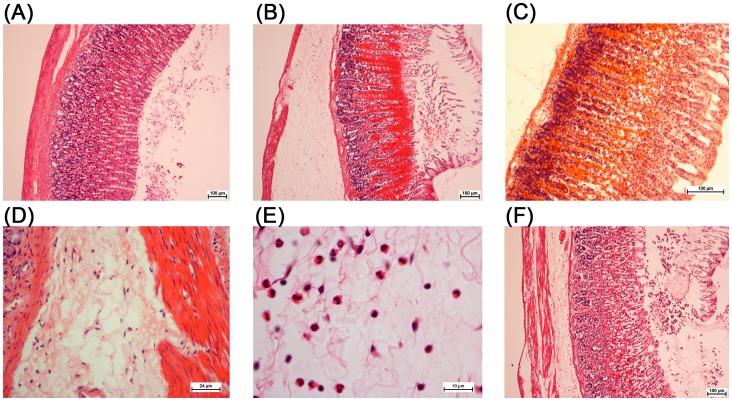
Hematoxylin and eosin staining evaluation of the gastric mucosa.The negative control and the complex control group have not any disruption to the gastric epithelium, submucosal edema or leucocyte infiltration (A). The lesion control group has extensive edema in the submucosal layer (B). Moreover acute hemorrhagic gastric lesions with severe disruption to the epithelium penetrated deeply into the mucosa (C) along with leucocyte infiltration are also noticeable (D and E). The pre-treatments with the complex (4.362×10−5 M/kg) show mild superficial disruption to the gastric epithelium (F).